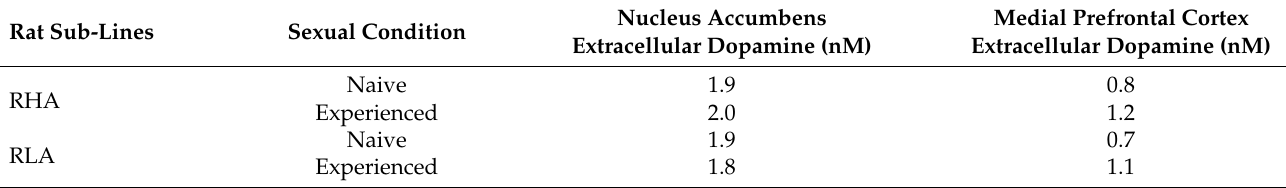
Table 12. Basal levels of extracellular dopamine in the dialysate from the nucleus accumbens and the medial prefrontal cortex of RHA/RLA rat sub-lines at the first (sexually naïve condition) and at the fifth copulatory test (sexually experienced condition) with a sexually receptive female